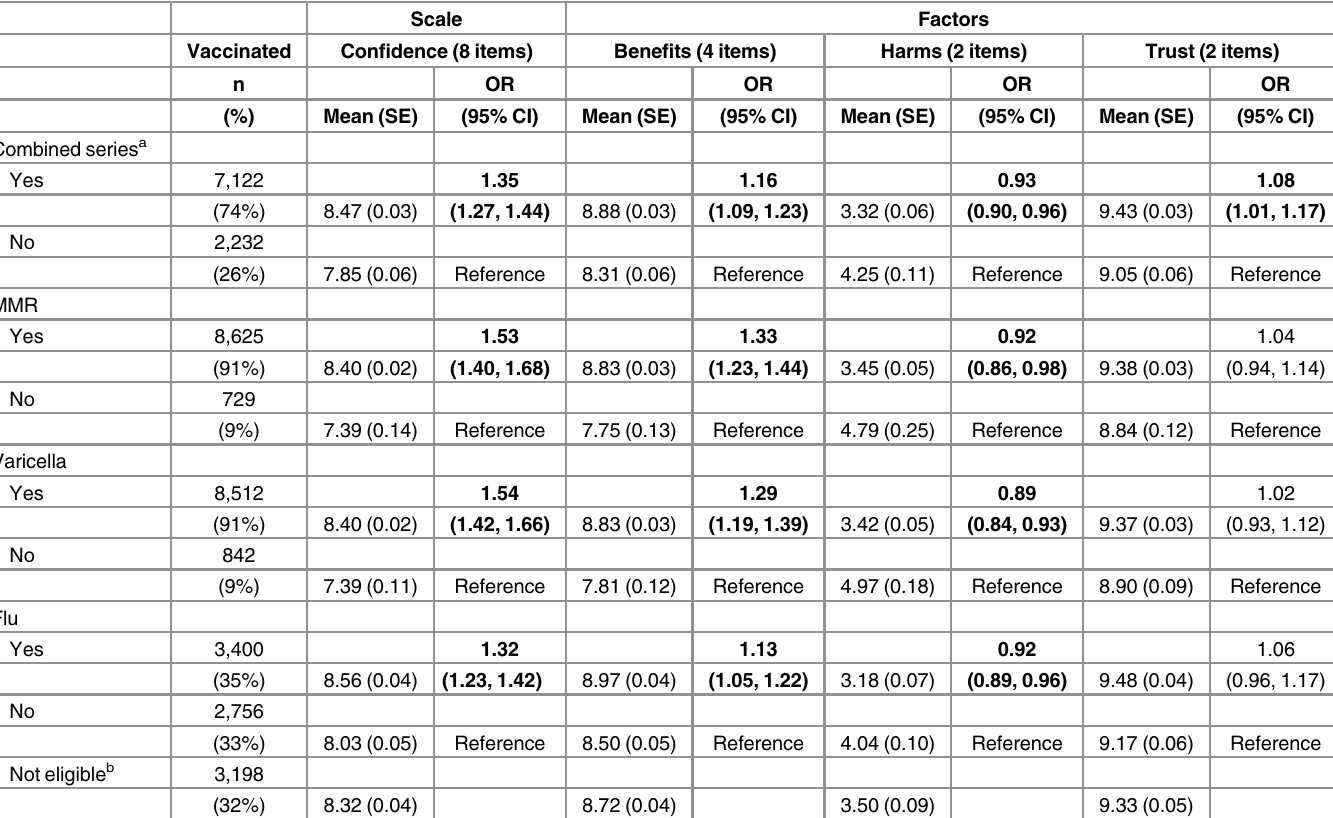
Table 4. Provider-reported vaccination status: Multivariable associations with scale and factor score means ( n = 9,354). Scale Factors